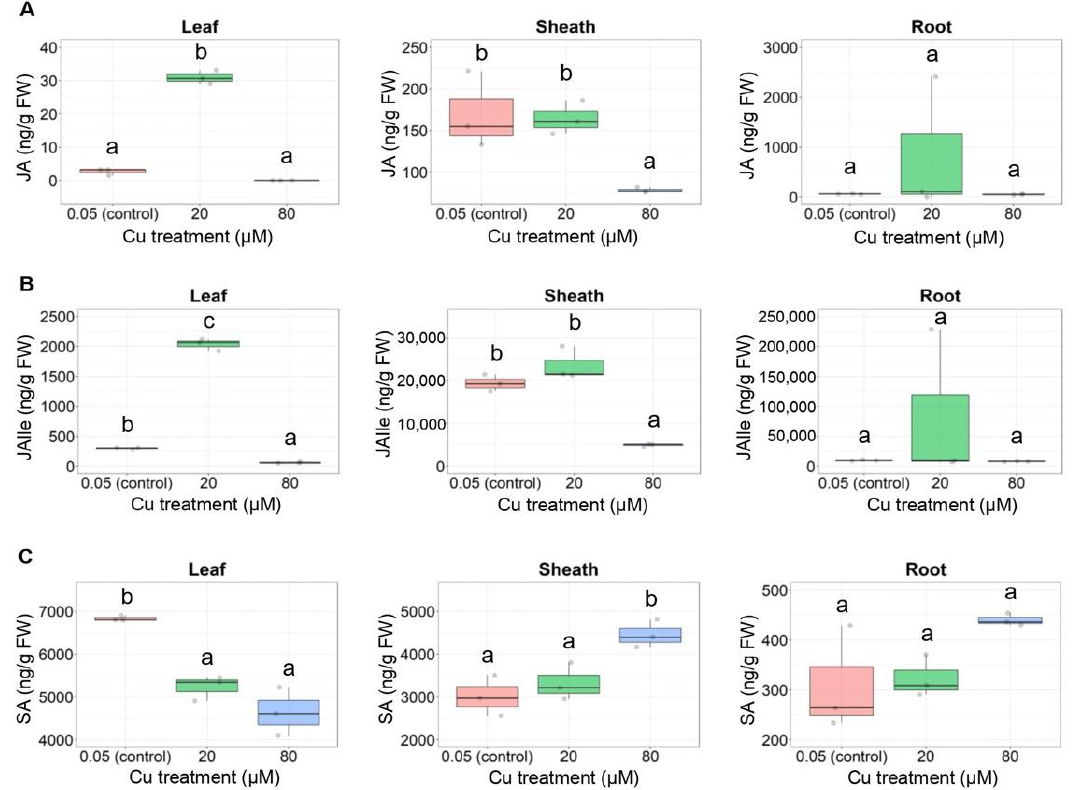
Figure 3. Effect of 20 and 80 µM Cu on defense-related phytohormone concentrations in rice tissues at 15 DAT: ( A ) Jasmonic acid (JA); ( B ) JA-isoleucine (JAIle) and ( C ) salicylic acid (SA) concentrations are shown in three tissues. Data are means ± SD ( n = 3). One-way ANOVA and Tukey’s post hoc test were used for phytohormone measurements in each tissue, with different letters denoting a significant difference ( p < 0.05).